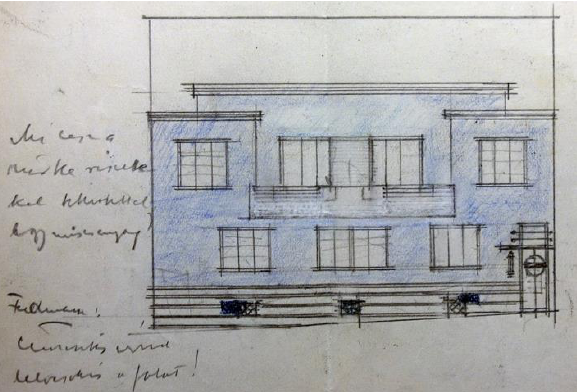
Figure 5. Original façade design. Architect: Victor Bohm, 1931. Source: MNL BAZML IV. 1906. 7262/1931.